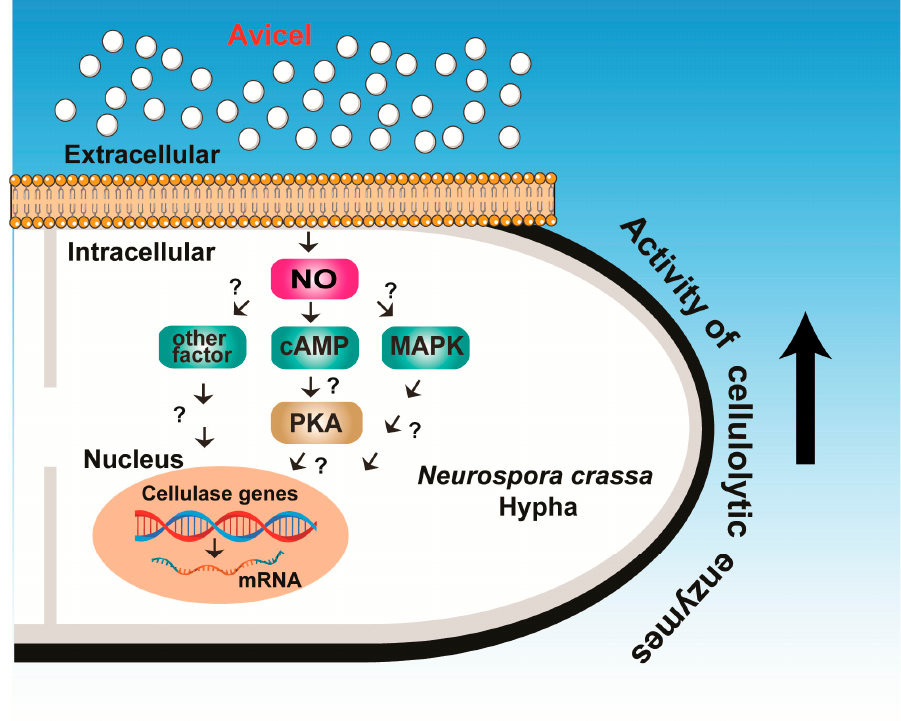
Figure 8. Proposed model for the mechanism of NO in fungal cellulase formation .